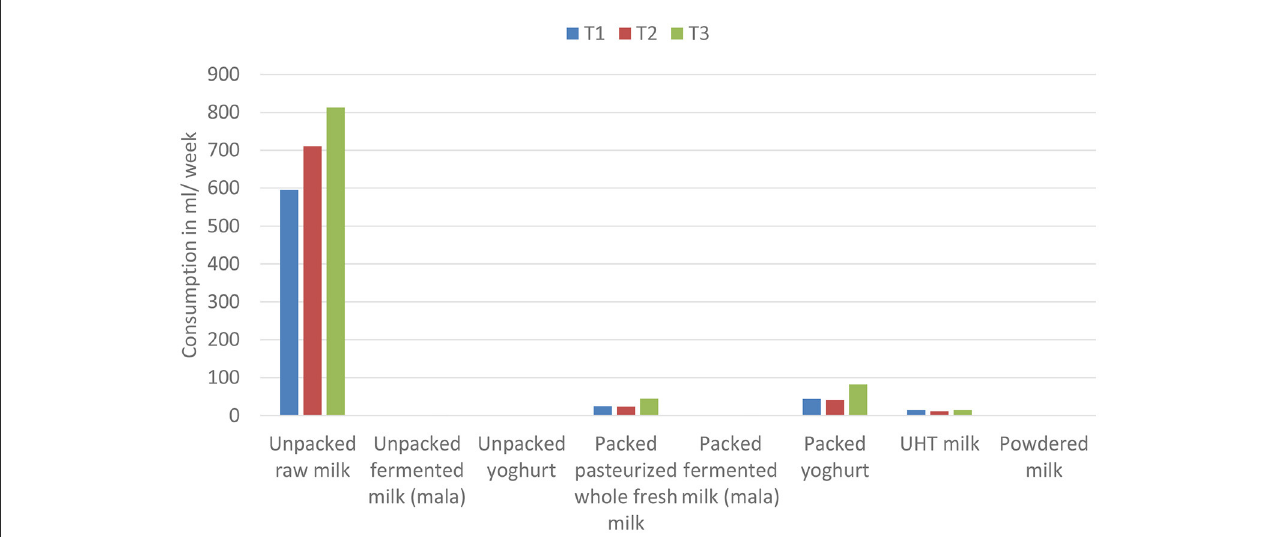
FIGURE2 Average consumption of dairy products of children 6–48 months per week, by income groups. T1 = Group with lowest income of < 100 USD/ month, T2 = Middle group with an income between 101 and 200 USD per month, T3 = Wealthiest group with an income between 201 and 300